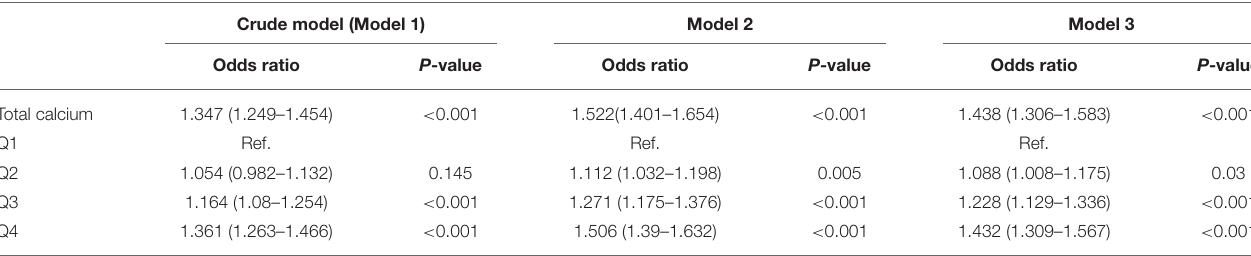
TABLE 2 | Association of calcium with